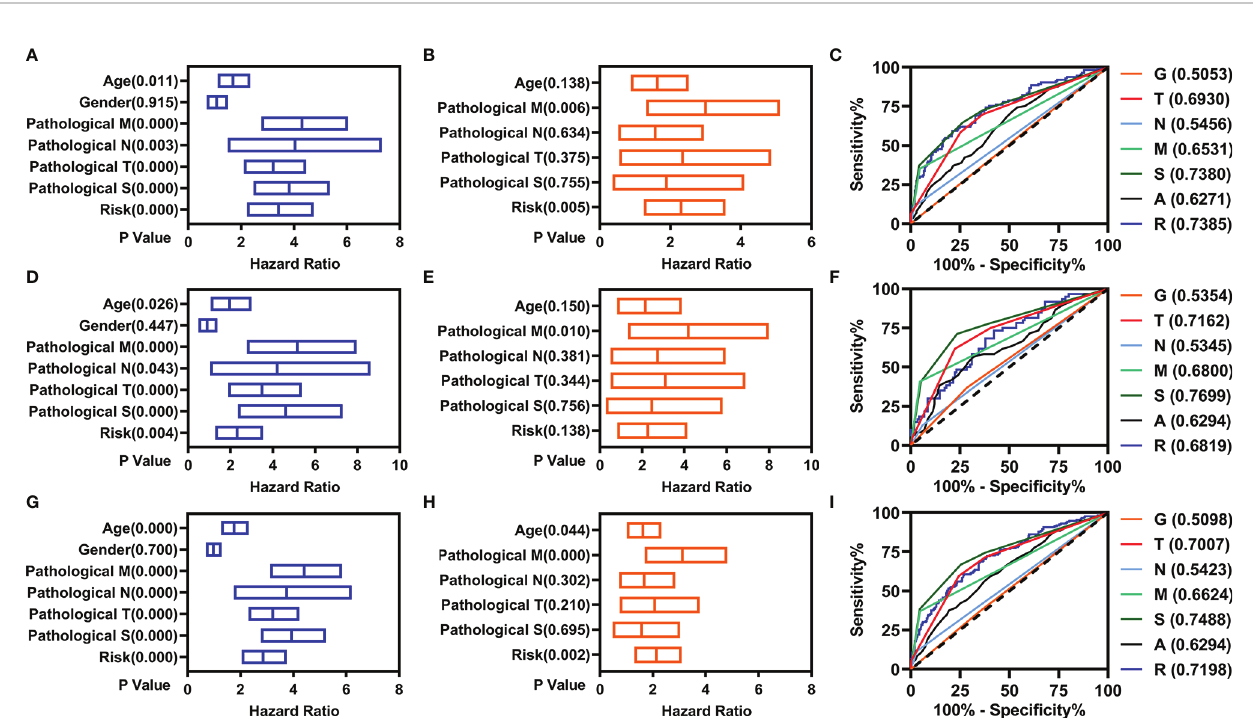
FIGURE 3 | Independent prognostic factors analyses. (A – C) For the training cohort: (A) Univariate Cox regression analyses, (B) multivariate Cox regression analyses, and (C) ROC curve. (D – F) For the validation cohort: (D) Univariate Cox regression analyses, (E) multivariate Cox regression analyses, and (F) ROC curve. (G – I) For the entire cohort: (G) Univariate Cox regression analyses, (H) multivariate Cox regression analyses, and (I) ROC